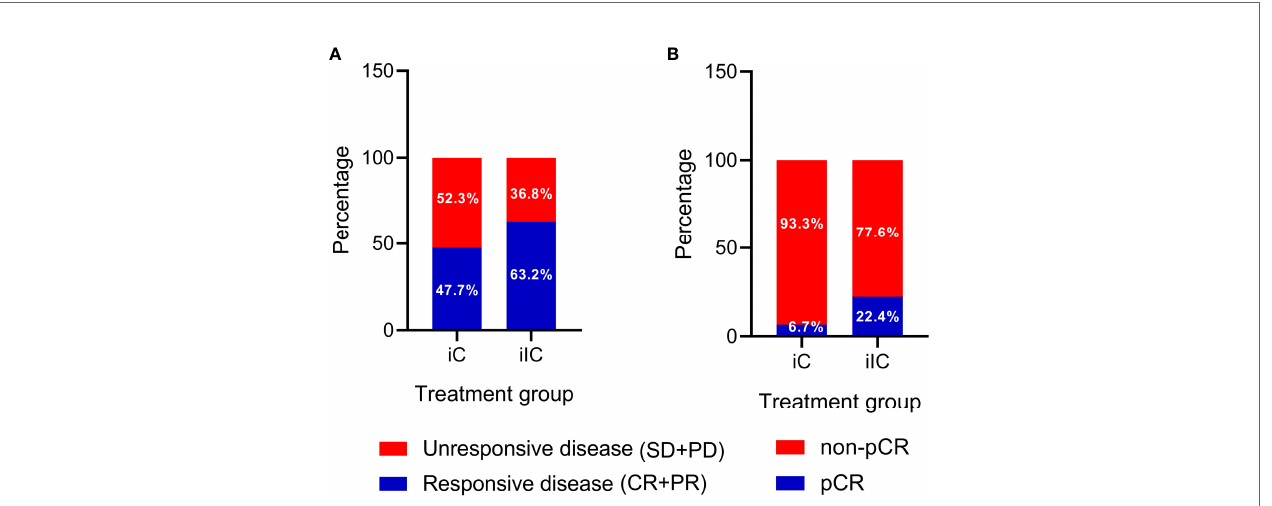
FIGURE 3 | Radiological and pathological responses between induction chemotherapy and induction immunochemotherapy. (A) Radiological assessment of tumor responses. Signi fi cantly higher responsive disease rate was observed in the iIC cohort. (B) Pathological assessment of tumor responses. Signi fi cantly higher pCR